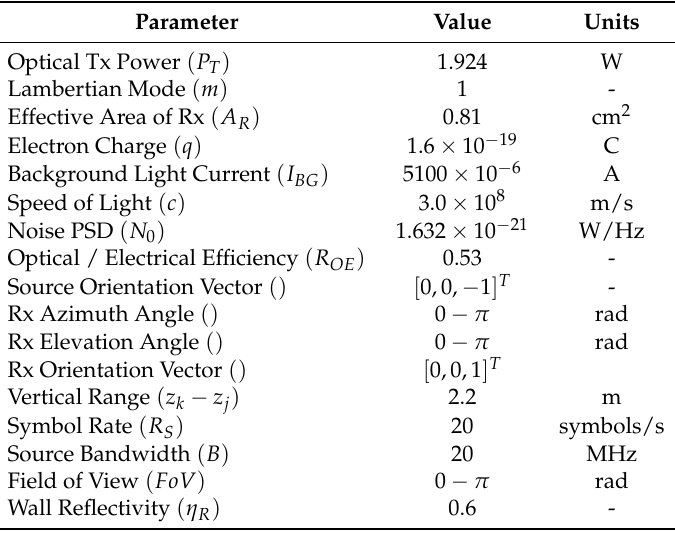
Table 1. Two Phase Algorithm